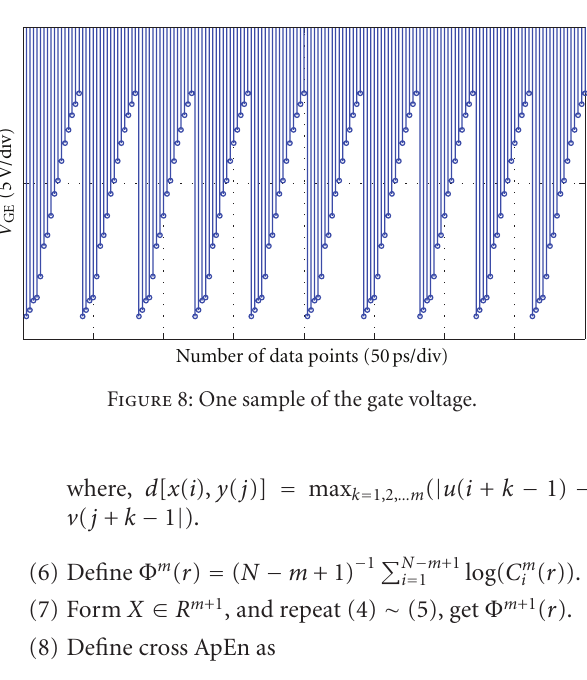
Figure 7: One data acquisition of the gate voltage.